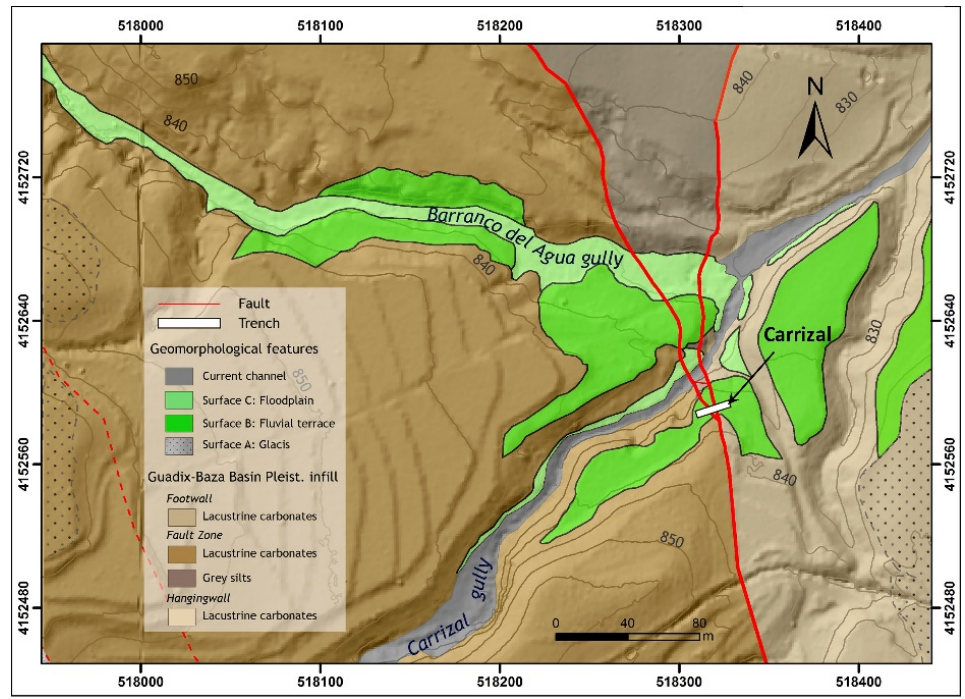
Figure 2. Geological map of an area of the central sector of the Baza Fault (Carrizal and Barranco del Agua), where the trench was located. Modified Torabi et al. [3].